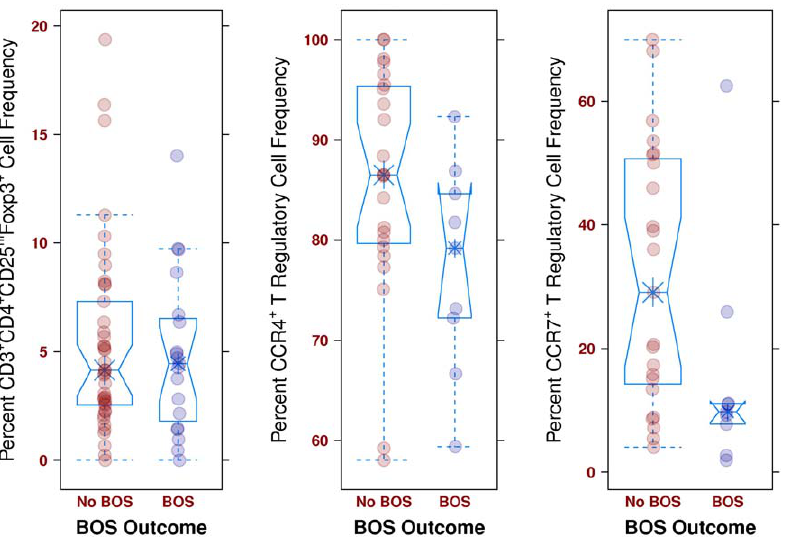
Figure 3. Boxplots of T regulatory lymphocytes and BOS outcomes. (left) A boxplot of all 60 evaluable samples for total Treg. This plot demonstrates that there are no differences in total Treg frequencies between those recipients who eventually develop BOS and those that do not (p=0.92). (middle) A boxplot of all 33 evaluable samples for Treg subsets. This plot demonstrates that there are no differences in CCR4 + Treg frequencies between those recipients who eventually develop BOS and those that do not (p=0.12). (right) A boxplot of all 33 evaluable samples for Treg subsets. The CCR7 + subset is associated with protection against BOS (p=0.04).